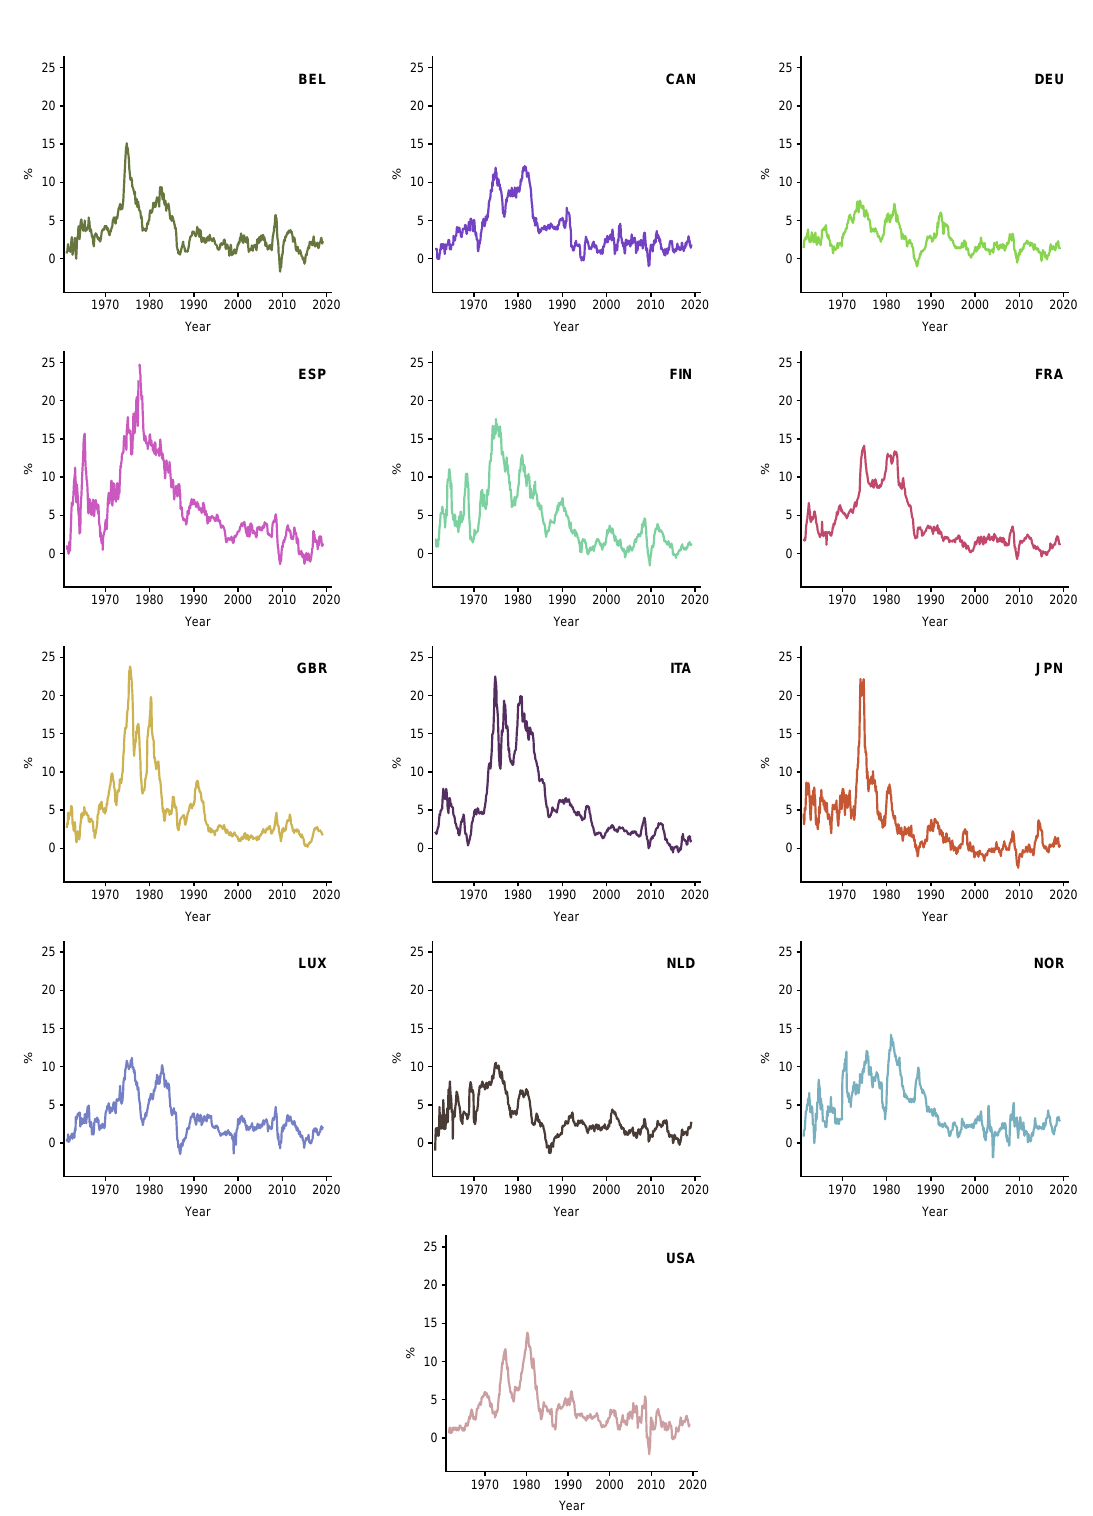
Figure 2. Inflation rates of OECD countries: Inflation rates are computed as year-on-year differences in the logarithm of monthly CPIs. The CPI base year is 2015. Data are obtained from the OECD database. The observation period is April 1961 to March